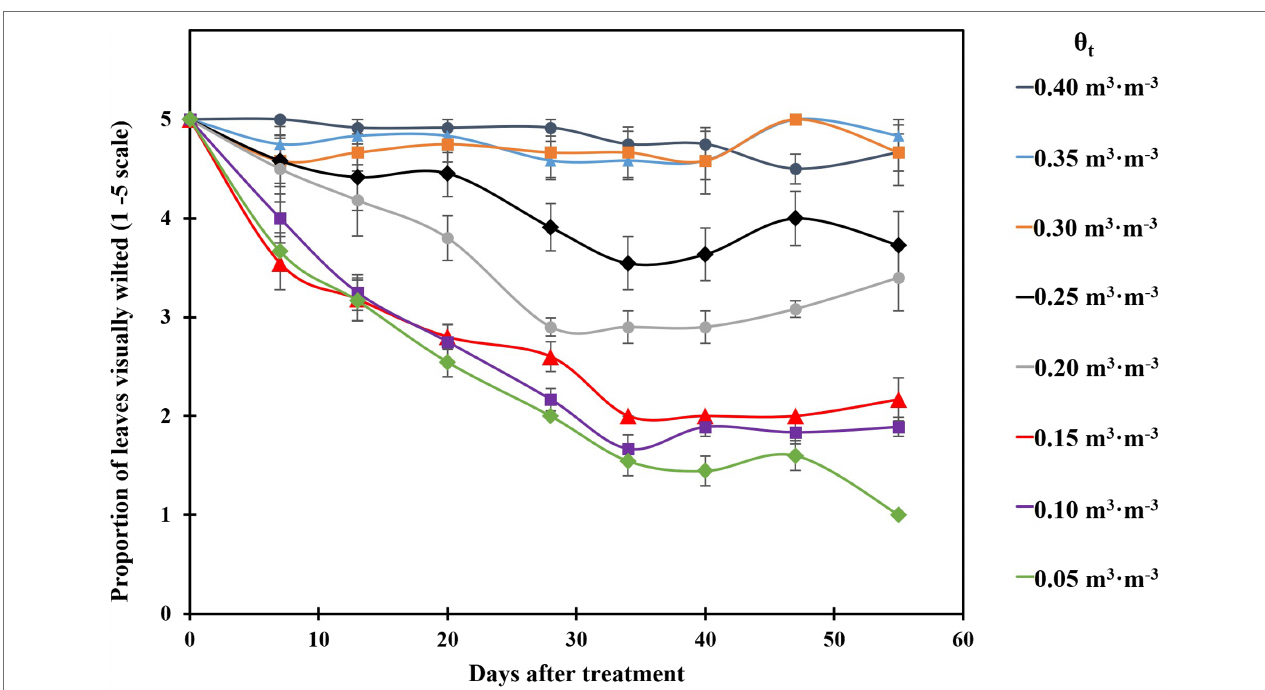
FIGURE 2 | Proportion of visibly wilted leaves of the plants grown at eight substrate volumetric water content treatments ( θ t ) during the experiment. Plants were rated on a scale of 1–5, where 1 = over 65% of the leaves wilted; 2 = 35–65% of the leaves wilted; 3 = up to 35% of the leaves wilted; 4 = less than 10% of the leaves wilted; 5 = plant was fully turgid (Zollinger et al., 2006). Error bars represent SEs of 12